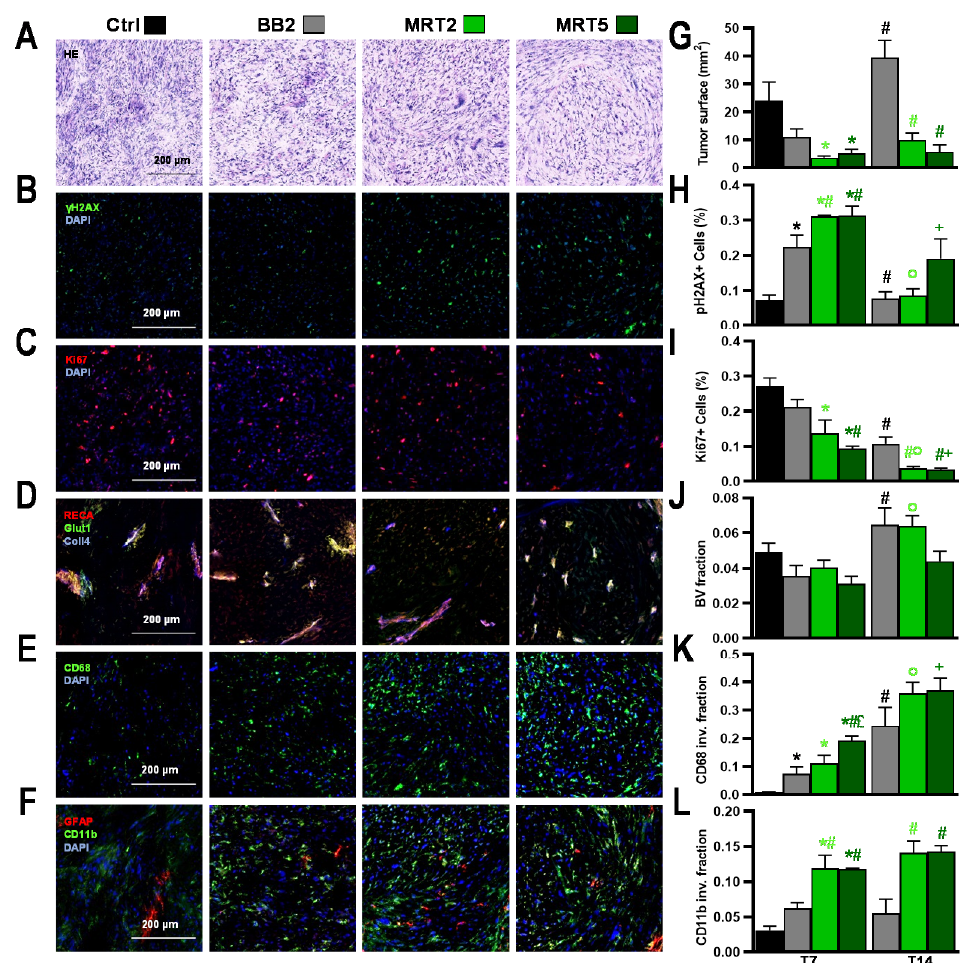
Figure 4. Pathology and quantitative immunolabeling characterization of irradiation effects at 7 days after 9L tumor irradiations. ( A – I ) Analysis of tumor lesions 7 days after BB2, MRT2, or MRT5 irradiations or 17 days after tumor implantation in untreated rats (control). ( A ) Hematoxylin and eosin staining: Irradiated tumors displayed a lower cell density than unirradiated tumors (Ctrl). While ( B ) γH2AX-reactivity was increased, ( C ) Ki67-staining decreased after MRT, in particular after MRT5. ( D ) Collagen-4, RECA-1, and GLUT-1 immuno-staining indicated vessel fractionation and